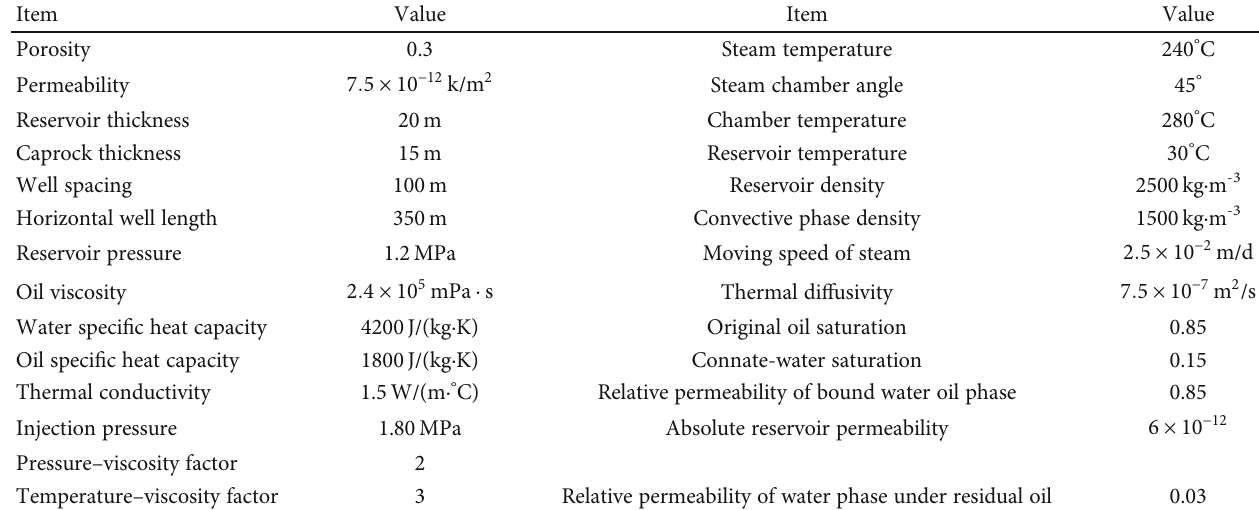
Table 1: Model veri fi cation parameter table.